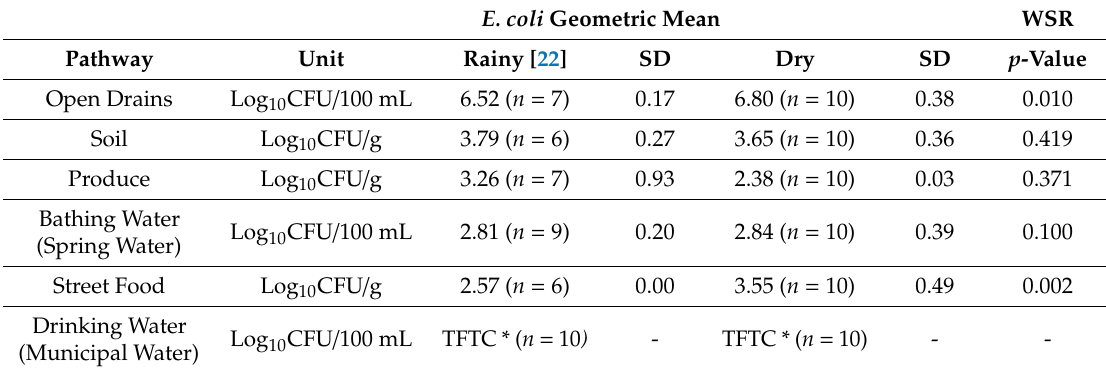
Table 2. E. coli geometric mean and Wilcoxon signed-rank (WSR)